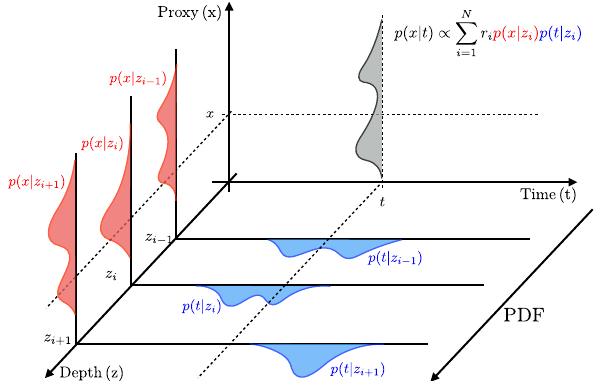
Figure 1. Schematic of converting time axis uncertainties into proxy axis ones. Schematic illustrating the key ideas of the proposed approach to represent proxy records dated by counting layers as se- quences of probability densities. In this diagram, the measurements of the proxy x and the corresponding calendar age t are indicated at three different depths z i − 1 , z i , and z i + 1 . The uncertainty distri- butions p ( x | z ) of the proxy measurement processes are depicted in red, and those of the calendar ages p ( t | z ) in blue. For a prescribed time t , the final probability distribution p ( x | t ) of proxy values is given as the normalized average of p ( x | z ), weighted by the corre- sponding contributions of all age uncertainty distributions p ( z | t ). Note that the x and t axes play a different role than the z axis, since a sum is taken over the latter to obtain p ( x | t ); see the Methods sec- tion for further